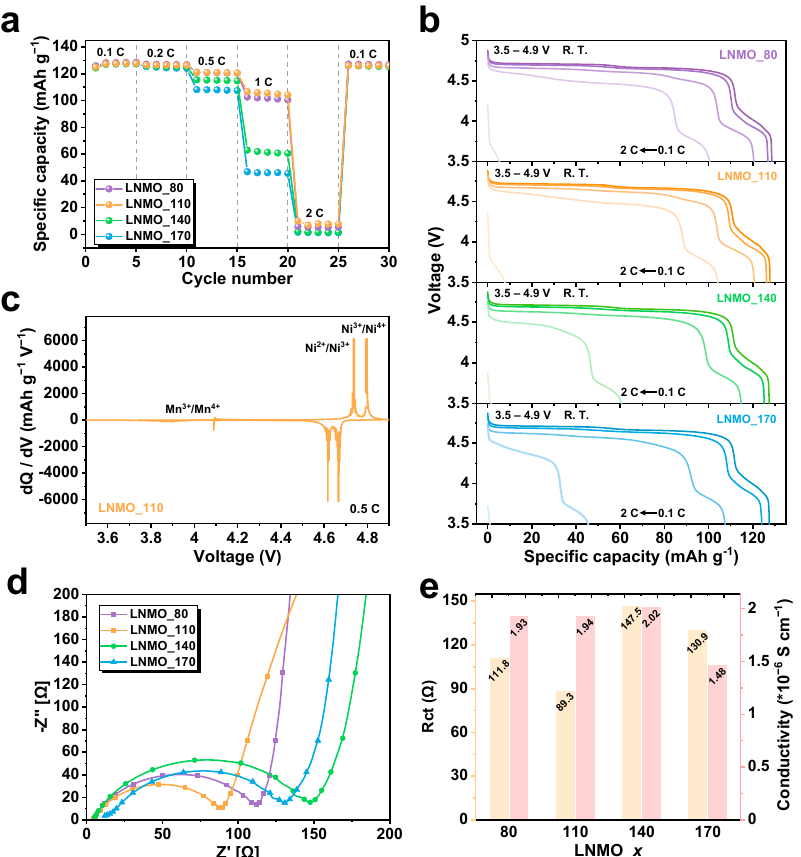
Figure 6. ( a ) Rate performance and ( b ) Discharge pro fi les at di ff erent rates of LNMO_ x samples. ( c ) Di ff erential capacity curves of LNMO_110. ( d ) EIS curves of fresh cells and ( e ) R ct fi tt ing values and conductivity results for LNMO_ x samples.